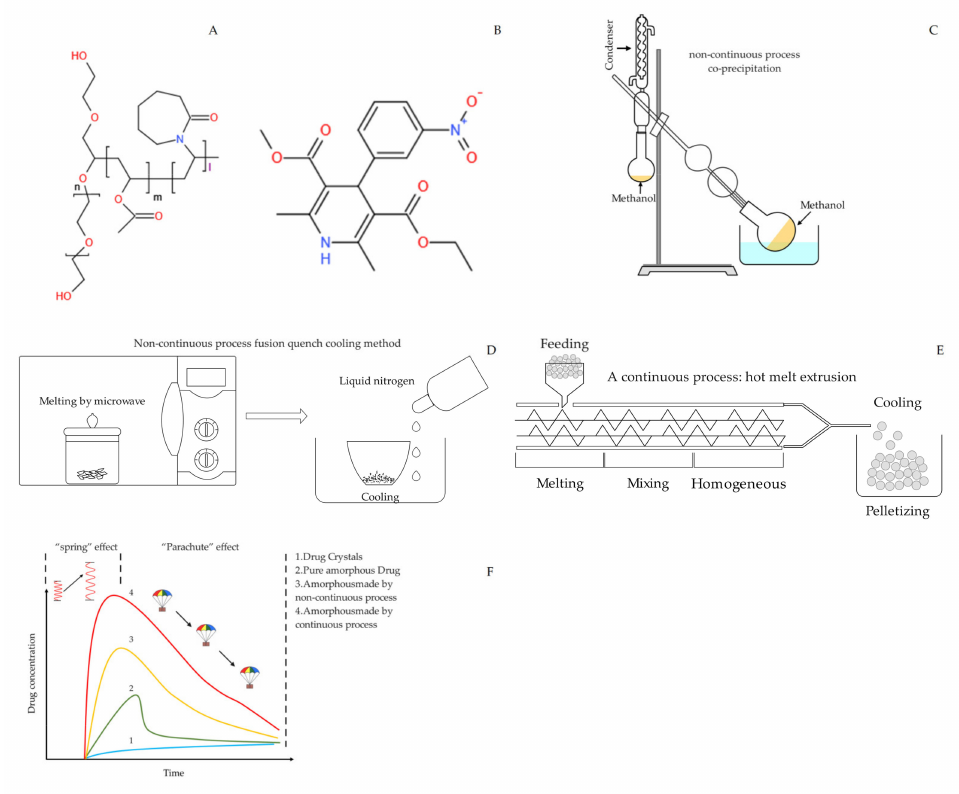
Figure 1. Chemical structures of drug and polymer ( A ) Soluplus ® ; ( B ) NIT. Preparation process ( C ) Schematic diagram of co-precipitation process; ( D ) Schematic diagram of fusion/quench cooling process; ( E ) Schematic diagram of hot melt extrusion progress. ( F ) Illustration of the spring-parachute process associated with saSMSDs made by continuous and non-continuous preparation processes and other control